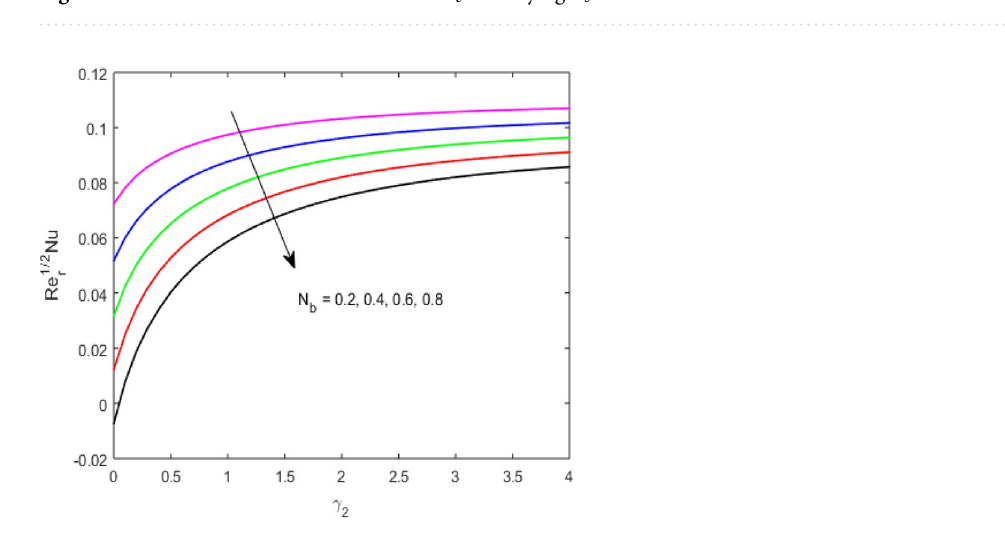
Figure 9. Concentration distribution versus K c for varying K s .